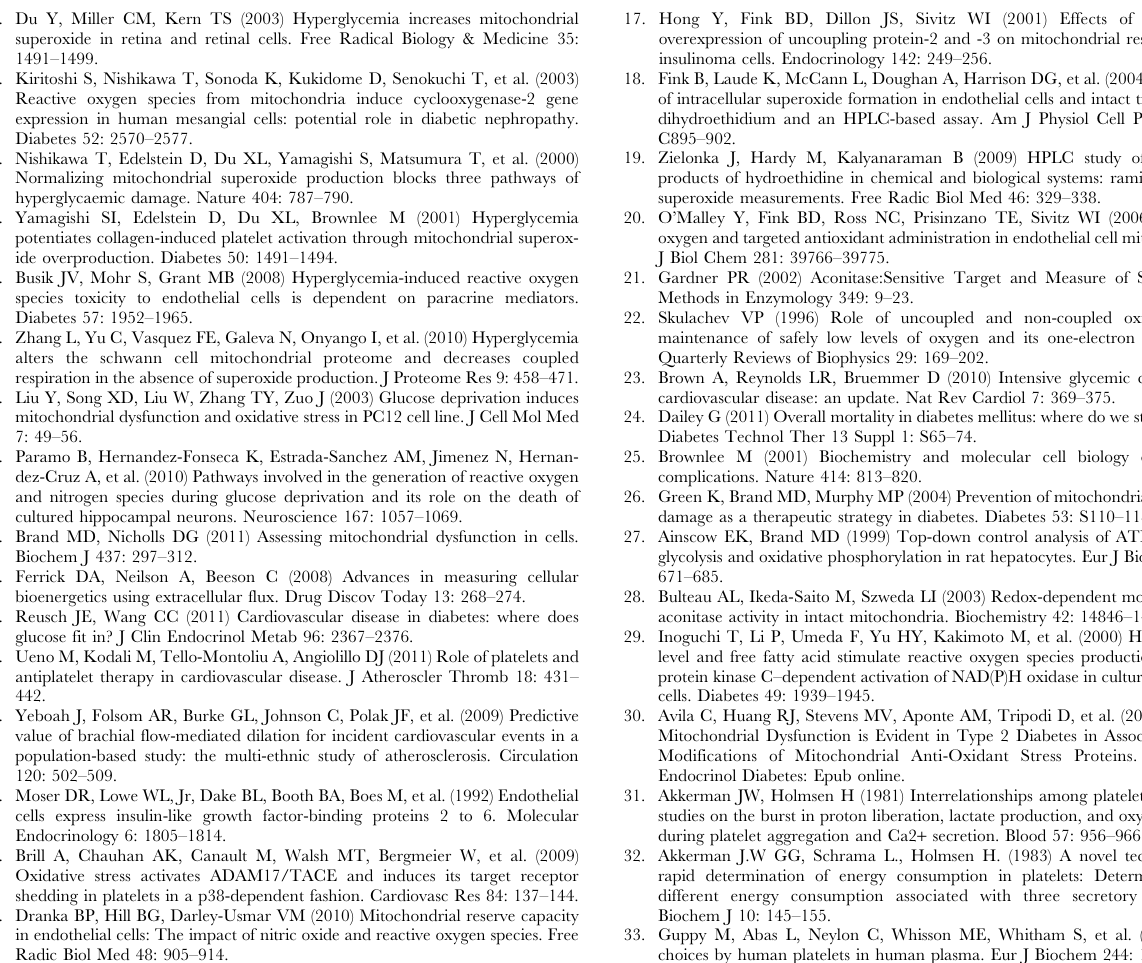
confluency and exposed to 5.5 or 25 mM glucose for 18 h before preparation of cell extracts. Panels D to E) Quantification of porin and OxPhos as a function of whole cell protein. Panel F) DNA/ protein ratios in the same cell extracts. Panels G and H) Quantification of porin and OxPhos protein as a function of whole cell DNA. Glucose exposure did not significantly alter these parameters. n = 8–10 repetitions for each group. (TIF) Figure S6 Glucose does not alter oxidation of MitoSOX in BAE cells. Cells were grown to confluency, then exposed overnight (18 h) to 5.5 or 25 mM glucose. Some cells exposed to 5.5 mM glucose were then treated with Antimycin A (10 m M) for 60 min. HPLC was carried out as described in ‘‘methods’’, main manuscript. Upper tracings in each panel depict detection by UV. Lower tracings depict fluorescence. The major peak, eluting at 15.6 minutes, was enhanced by Antimycin A, a positive control, known for its strong induction of mitochondrial superoxide through action on Coenzyme Q redox cycling in Complex III. A) Cells exposed to 5.5 mM glucose; B) 25 mM glucose or; C)